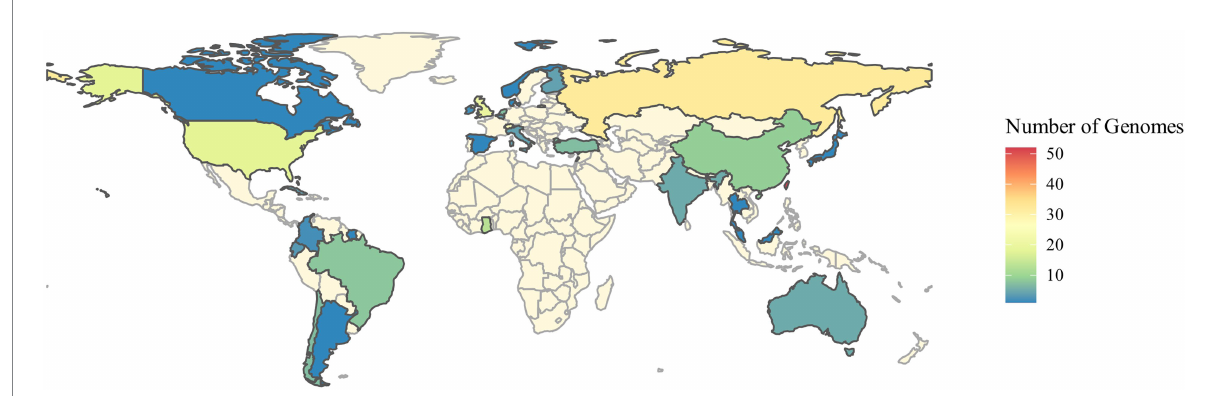
FIGURE 1 Spatial distribution of the isolates according to the information presented in the NCBI